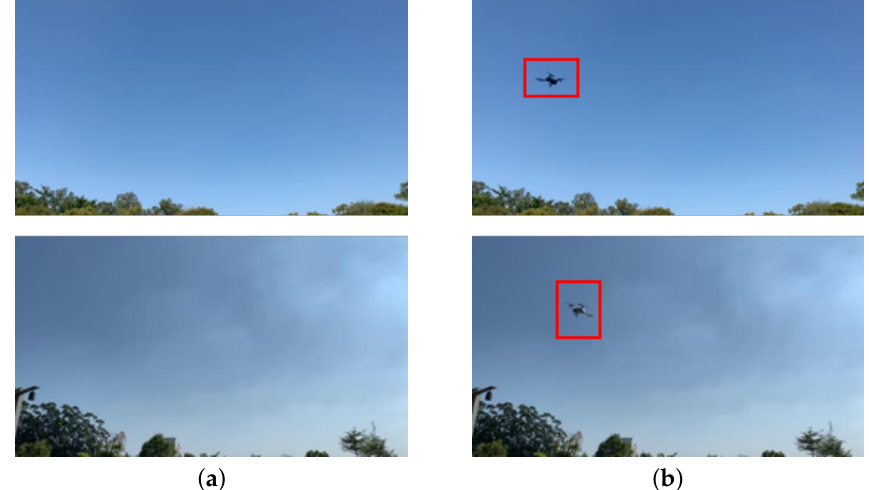
Figure 4. Part of the dataset in the stage of detecting abnormal behavior: ( a ) normal image, i.e., there is no object in the sky; ( b ) abnormal image, i.e., an object in the sky exists.